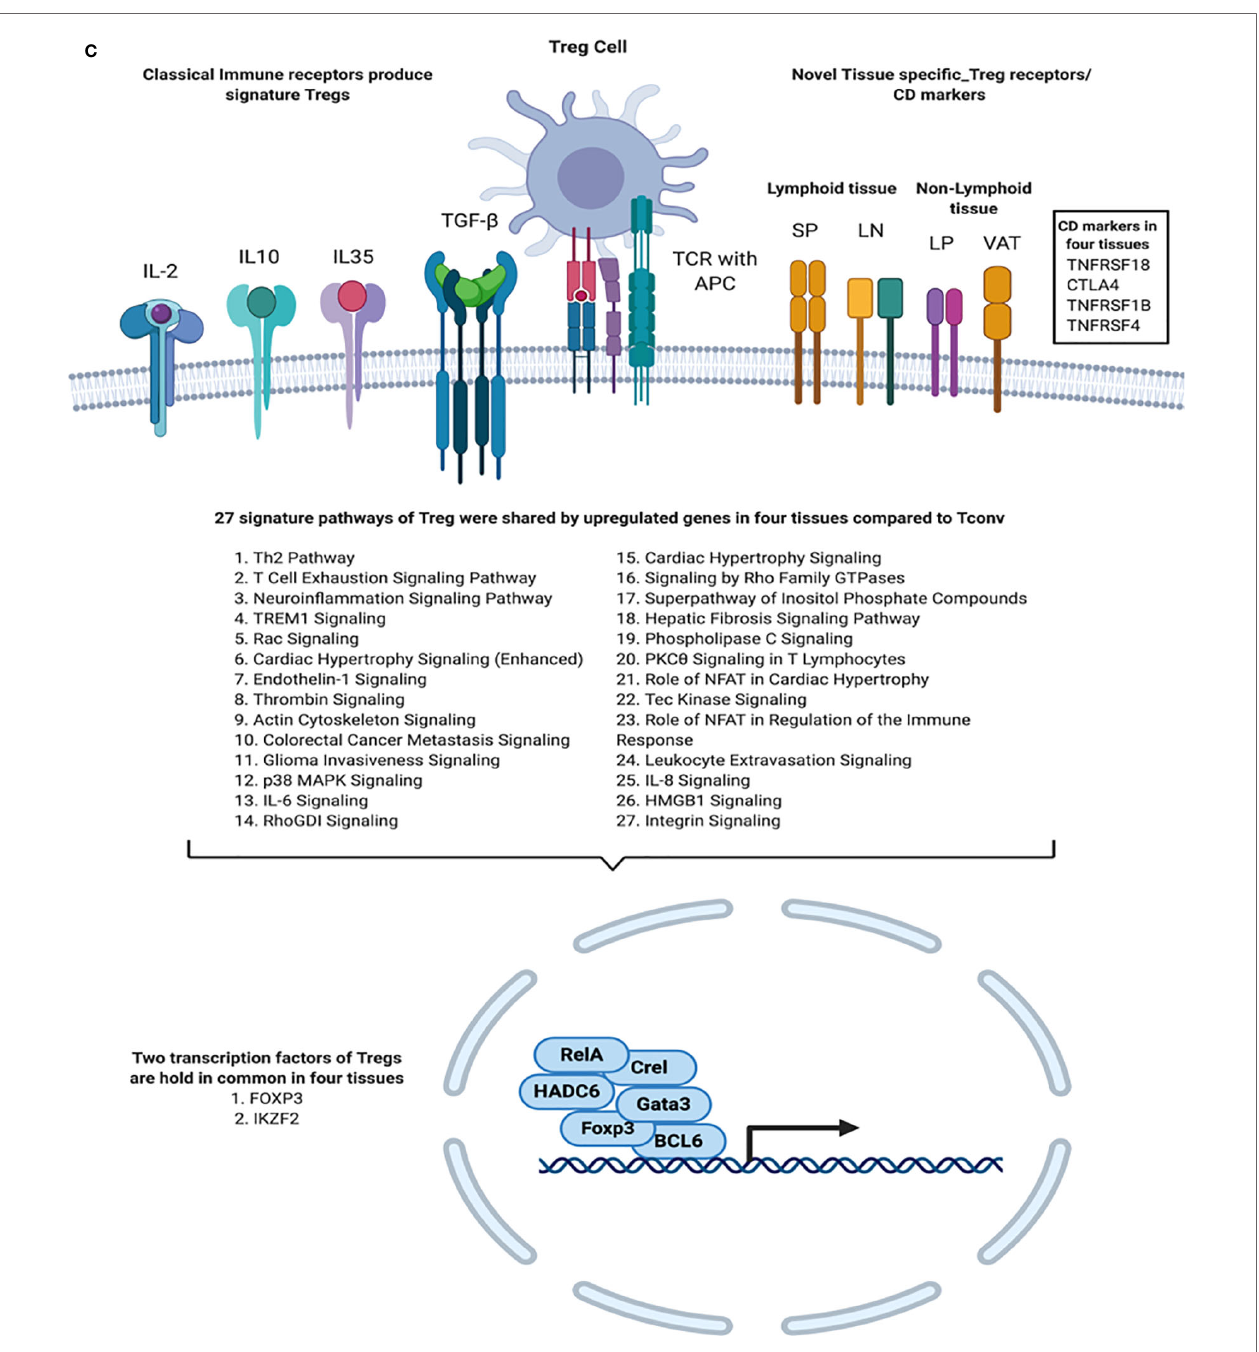
FIGURE 11 | (A) A new working model: Stem cell-shared secretomes and transcription factors shared by tissue Treg make tissue Treg as the fi rst T cell type with dual functions of immunosuppression and tissue repair. (A) Tissue Treg from spleen, lymph nodes (LN), intestine (int), and visceral adipose tissue (VAT) have been pro fi led in eight aspects. (B) Stem cells in tissues have a special microenvironment or niche in maintaining the stemness with dual functions of self-renewal and differentiate into progenitor cells and differentiated cells. Similar to the stem cells in tissues, tissue Treg also have a special niche in maintaining our newly proposed Tregness with immunosuppression and tissue repair. (B-1) Hierarchy of stem cell in homeostasis and regeneration. Stemness niche signal drives stem cell differentiate to specialized lineage populations that maintain tissue homeostasis. During tissue damage, cells can be dedifferentiation in order to increasing proliferation of stem cells. PMID: 25308311. (B-2) Hierarchy of Tregs in immunosuppression, tissue repair, and maintaining homeostasis. Tregness maintaining niche signal upregulates tissue speci fi c Treg cytokines and secretome in stem cells cytokines and secretome, which drives Tregs participating in tissue repair and homeostasis. (C) Stem cell-shared secretomes and transcription factors make tissue CD4 + Foxp3 + Treg as fi rst T cell type use a Treg niche to maintain their Treg- ness with dual functions of immunosuppression and tissue